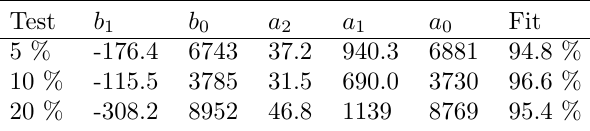
Table 2: Negative offset coefficients.